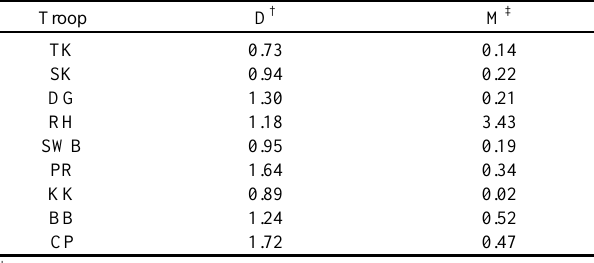
Fractional monitoring rate (Lowen and Dunbar